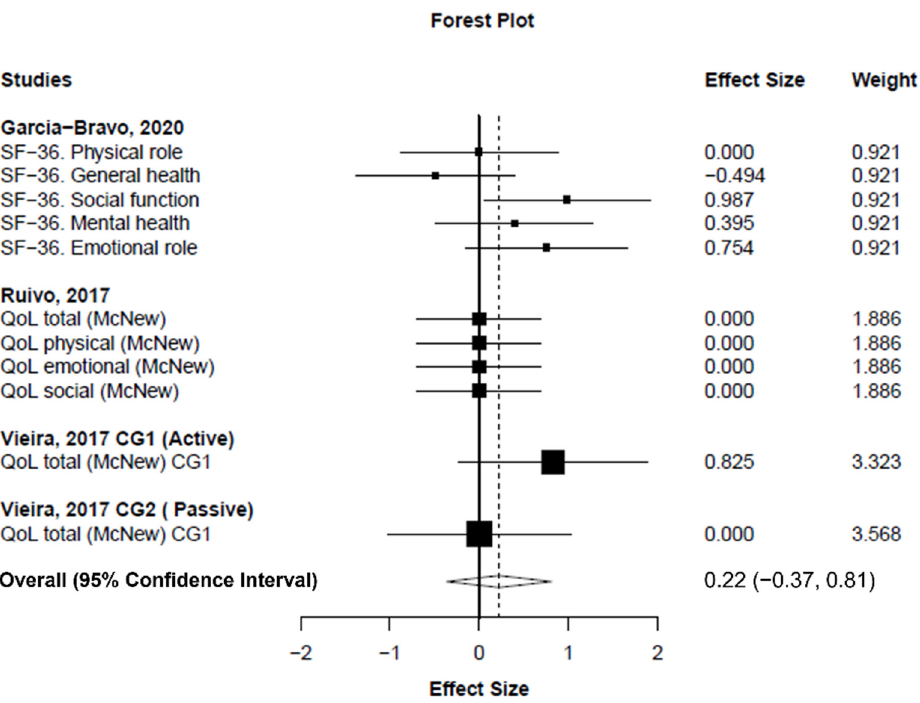
Figure 4. Forest plot showing the standardized mean difference between exergaming and conven- tional cardiac rehabilitation for quality of life. Standardized mean difference greater than zero favors